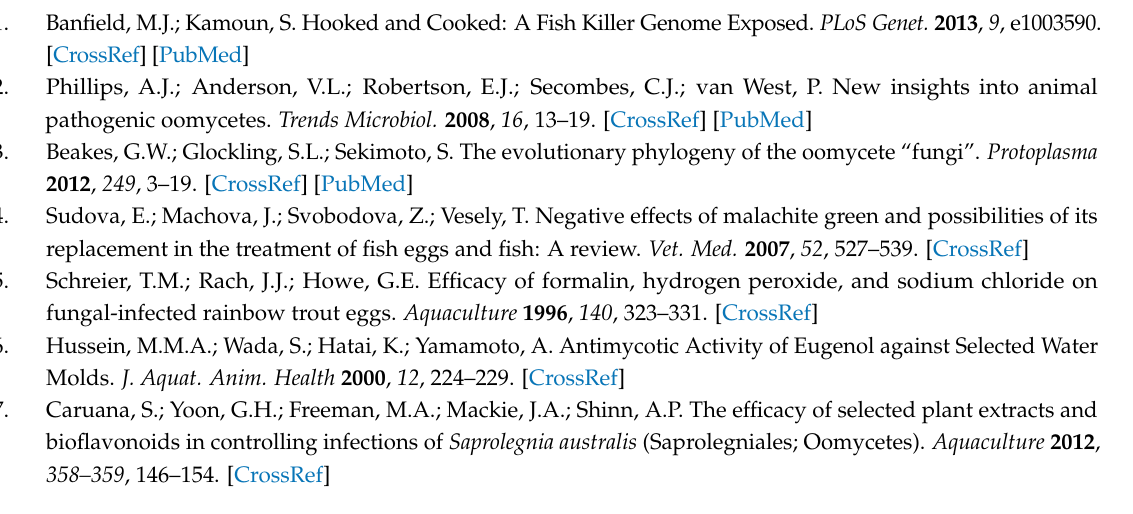
Supplementary Materials: The following are available online. Table S1: Descriptors obtained in gas phase and used for structure–activity relationship, Table S2: Descriptors obtained in solvent phase and used for structure–activity